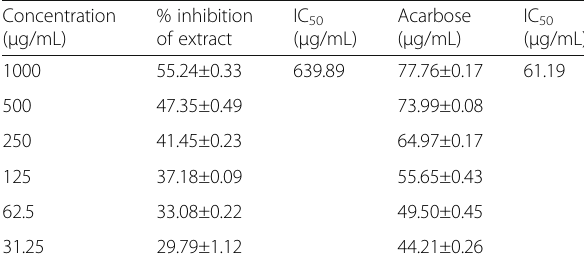
Table 3 α -Glucosidase inhibitory activity of Olax nana Concentration ( μ g/mL)